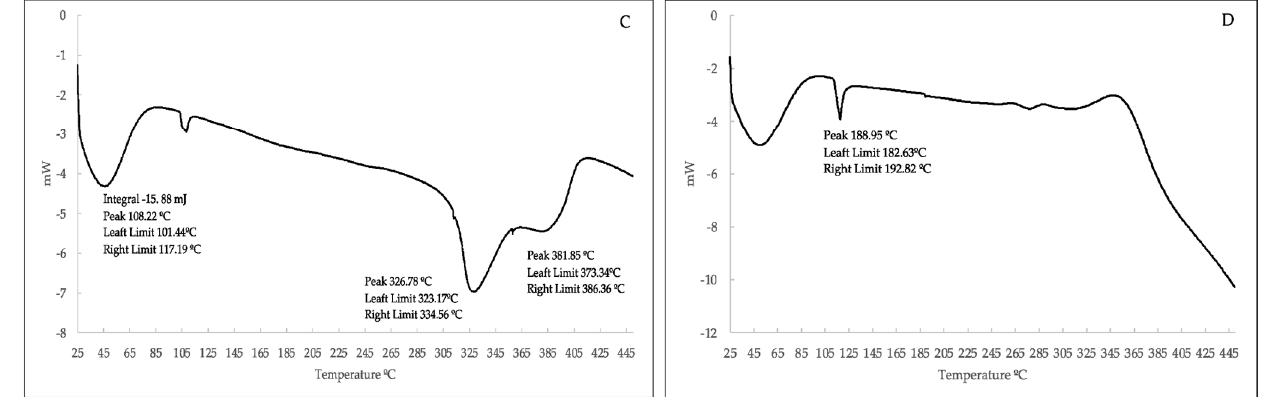
Figure 5. The differential scanning calorimetry (DSC) curves for the ( A ) β -cyclodextrin, ( B ) Fe 3 O 4 nanoparticles, ( C ) β -cyclodextrin-epichlorohydrin polymer, and ( D ) β -CD-EPI polymer-modified Fe 3 O 4 nanoparticles.